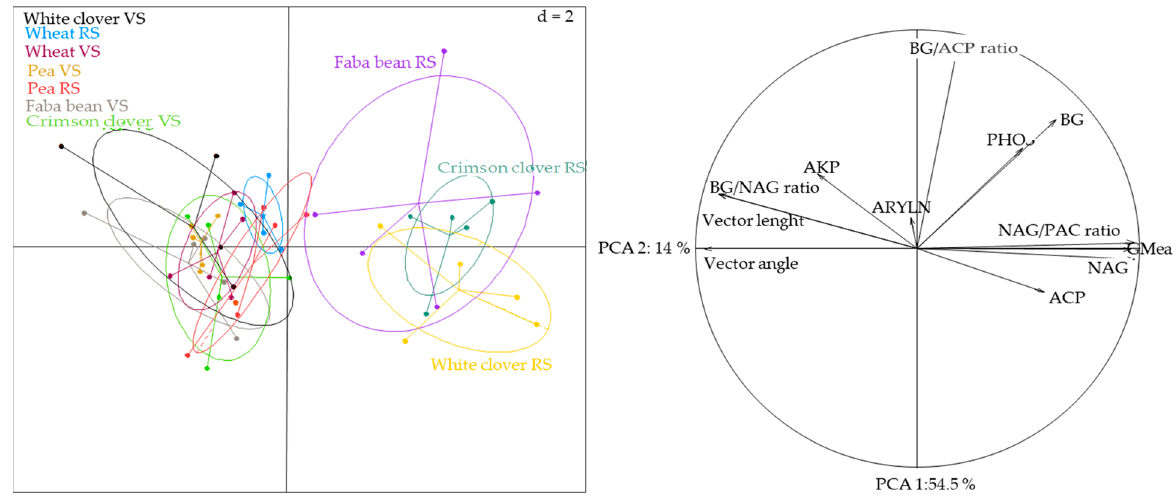
Figure 5. Principal component analysis (PCA) and correlation circle of the enzyme activities and indexes of microbial resource requirement. BG: β -glucosidase; NAG: N-acetyl-glucosaminidase; ACP:acid phosphatase; VS: vegetative stage; RS: reproductive stage; GMea: geometric mean.